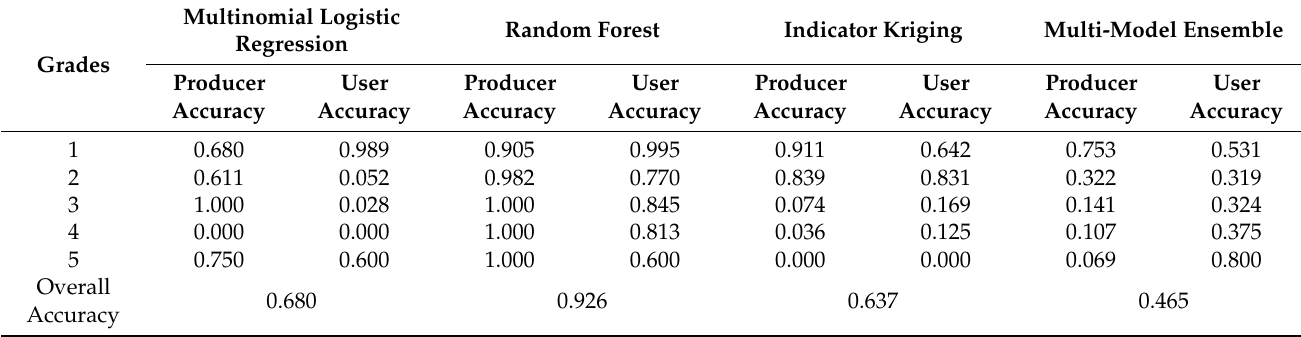
Table 2. Contingency table of the